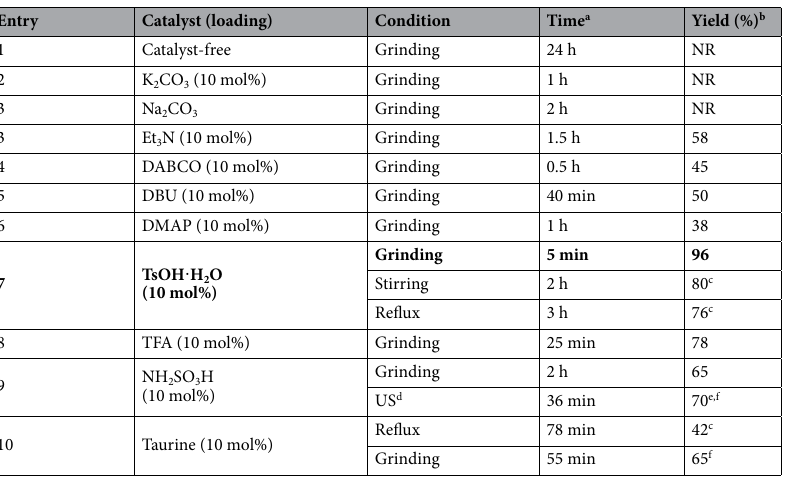
Table 1. Screening of catalytic system for the synthesis of 2-amino-3-cyano-4 H -chromenes. Reaction condition: Benzaldehyde 1 (1.0 mmol), malononitrile 2 (1.0 mmol), and 5,5-dimethylcyclohexane-1,3-dione 3a (1.0 mmol) in the presence or absence of catalyst(s) in H 2 O ( η = 0.35 μL/mg) as LAGs [ η = V (liquid; μL)/m (reagents; mg)] at ambient temperature. NR no reaction. Significant values are in [bold]. a Progress of the reaction was scrutinized by TLC. b Yields of the isolated products. c Reaction was carried out with 3 mL of water as the solvent. d Ultrasound irradiation. e Sonication was performed using an ultrasonic bath (model: SB-3200DT) with an operating frequency of 40 kHz and nominal power of 180 W. f Using 20 mol% of taurine.